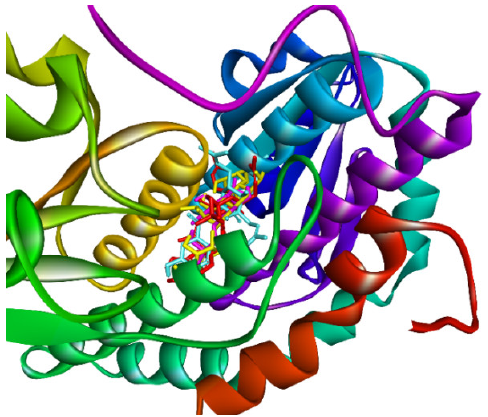
Figure 29. The best docking poses of ligand poses 158 (red), 35 (cyan), 83 (violet), and 172 (yellow) docked to the same active center on enzyme 2VF5.